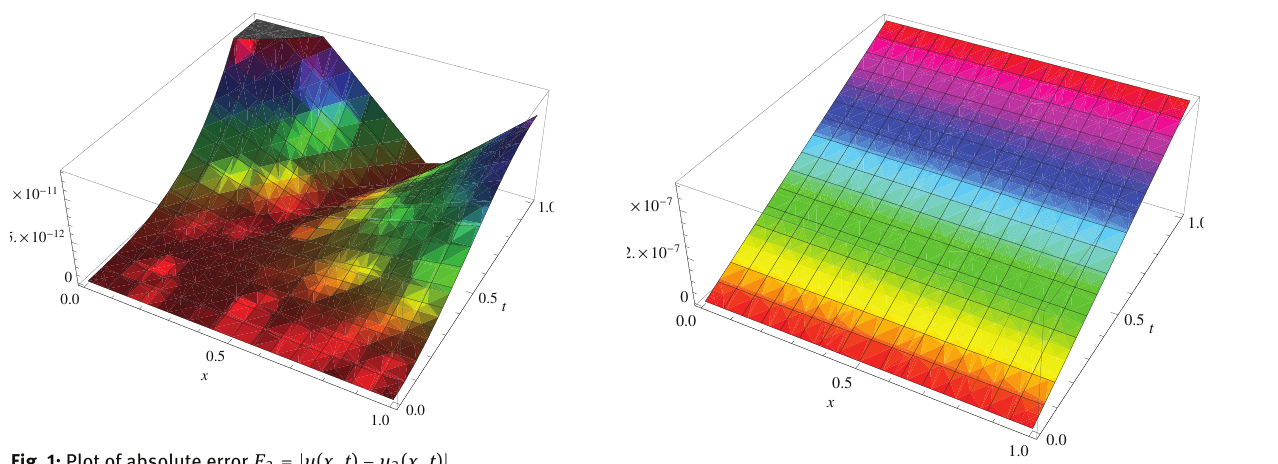
Fig. 1: Plot of absolute error E 3 = | u ( x , t ) − u 3 ( x , t ) | .